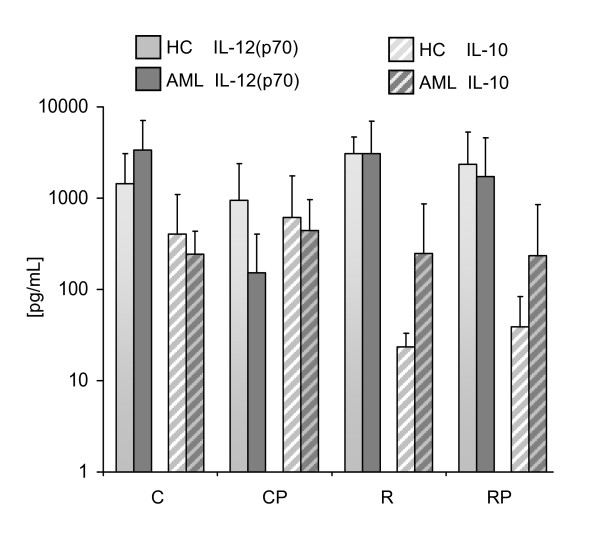
Cytokine secretion assessed by signal-3 assay. CD40L-transfected mouse fibroblasts were used as stimulators for DCs mimicking T cell contact. Supernatants were collected after 24 h of coculture. Cytokines were measured by standard ELISA. Independent experiments were performed with a number of n = 4-12 donors for C, CP, R, and RP in HCs and AML patients.